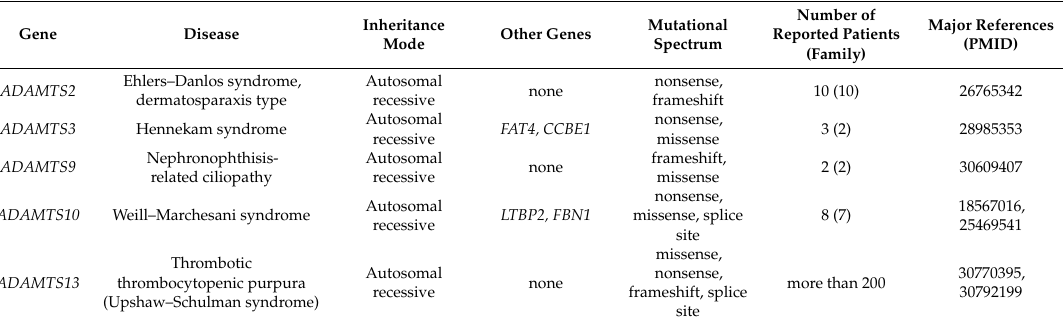
Table 1. ADAMTS family genes responsible for Mendelian disorders with strong evidence as of 2020. Gene Disease Inheritance Mode Mutational